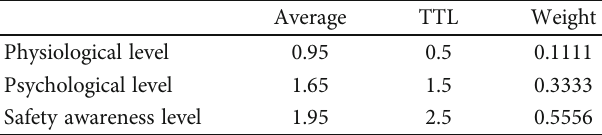
Table 5: Weight calculation results of precedence